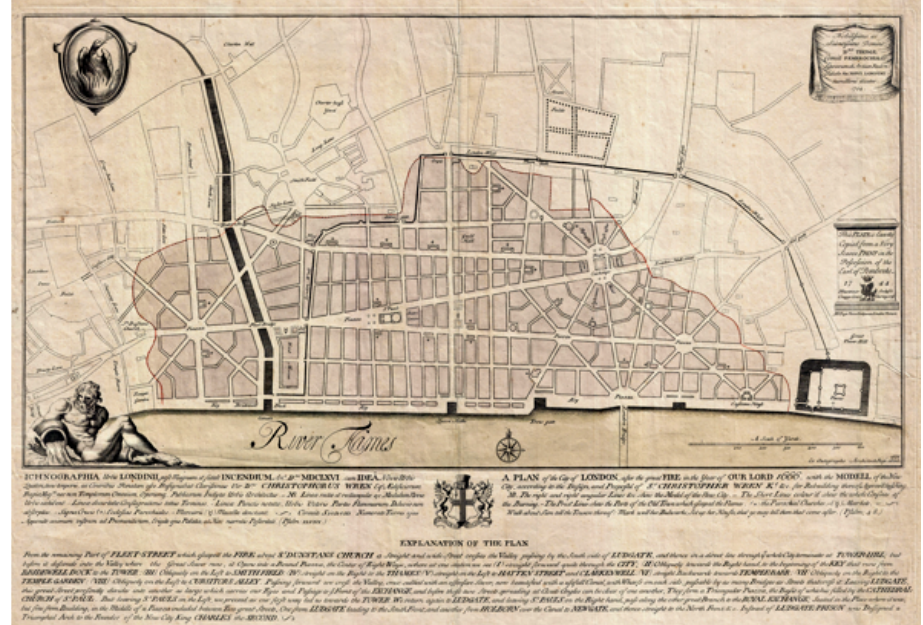
Figure 1. Sir Christopher Wren’s plan, never realized, for rebuilding London after the Great Fire of 1666 (plan dated 1744). is more problematic. In the U.S. it has led to a backlash against eminent